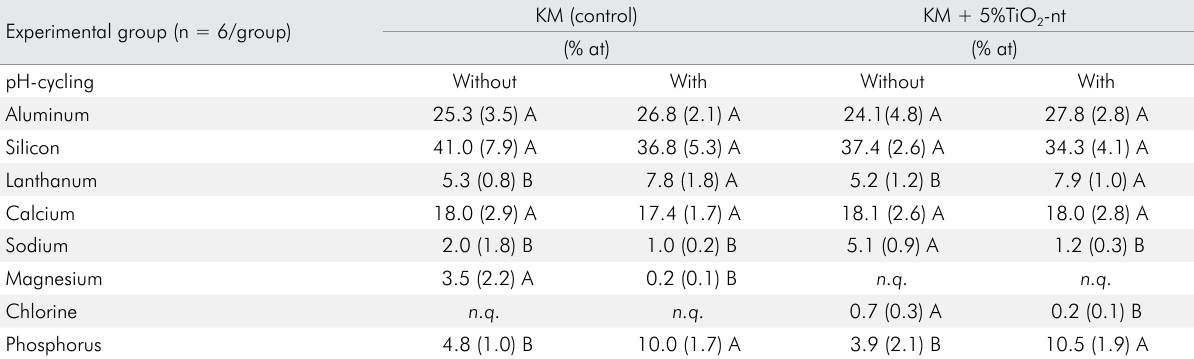
Table 2. Mean (standard deviation) values of EDS analysis (% at) of glass ionomer cements with or without of 5% TiO with or without